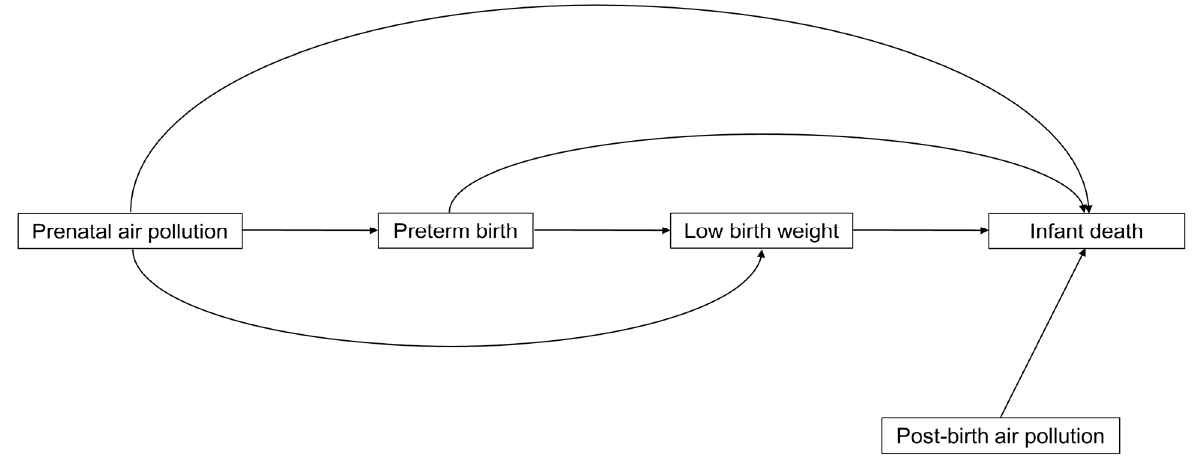
Figure 1. Graphical representation of the Structural Equation